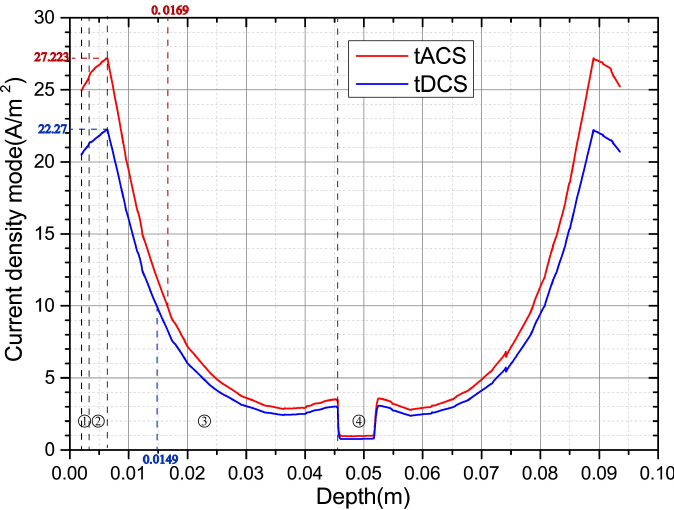
Figure 5. Current density distribution on the geometric center line of electrodes. 1 (cid:13) , 2 (cid:13) , 3 (cid:13) , and 4 (cid:13) illustrate the approximate current density distribution in the skin, fat, muscle, and bone layer, respectively.